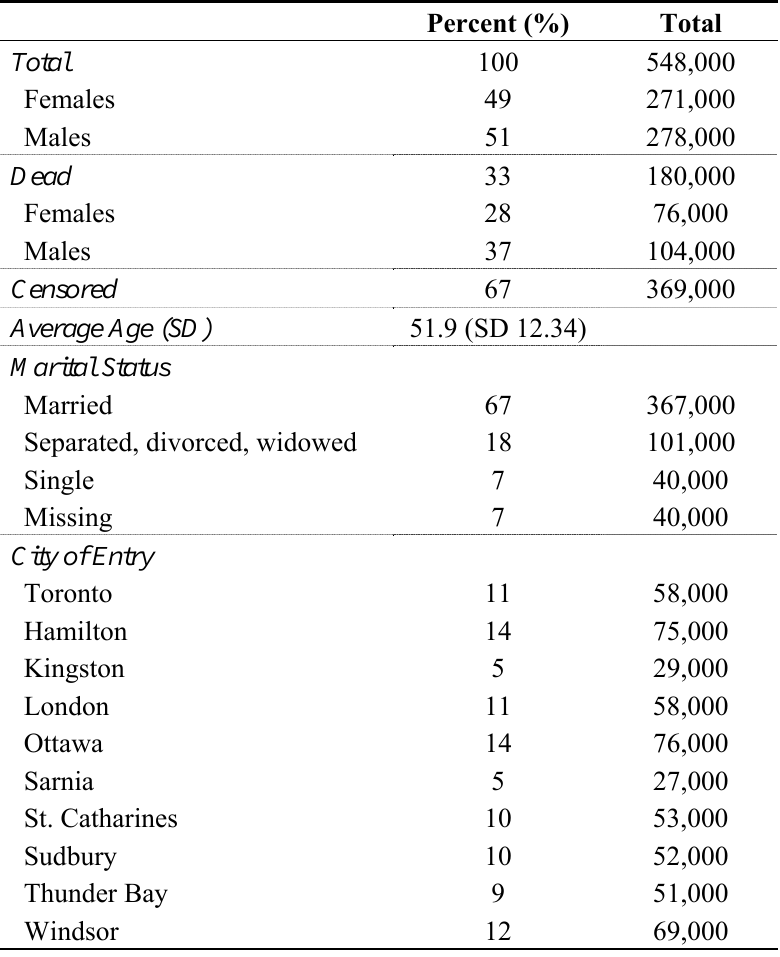
Table 1. Characteristics of Ontario tax